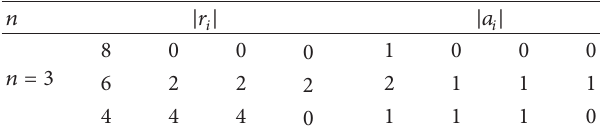
Table 1: Spectral-coefficient |𝑟 𝑖 | classification of all the three- variable threshold